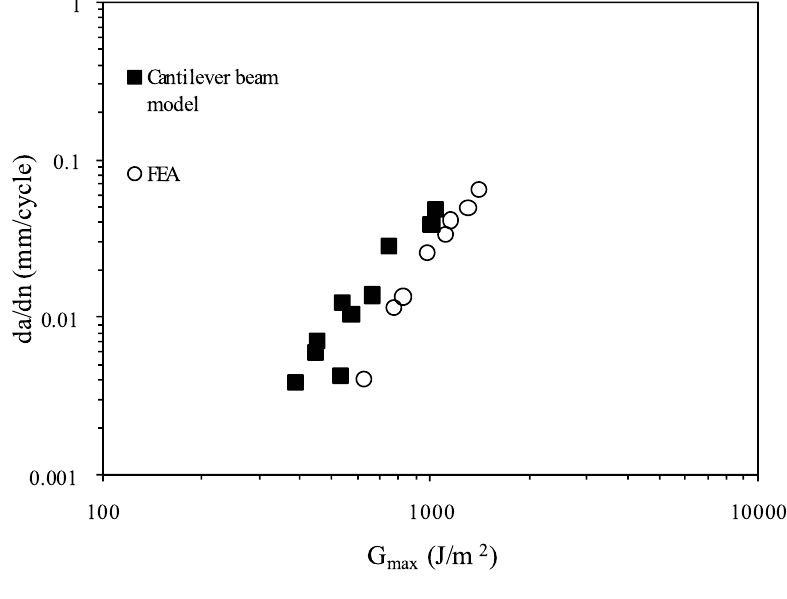
Fig. 12. Impact fatigue crack growth